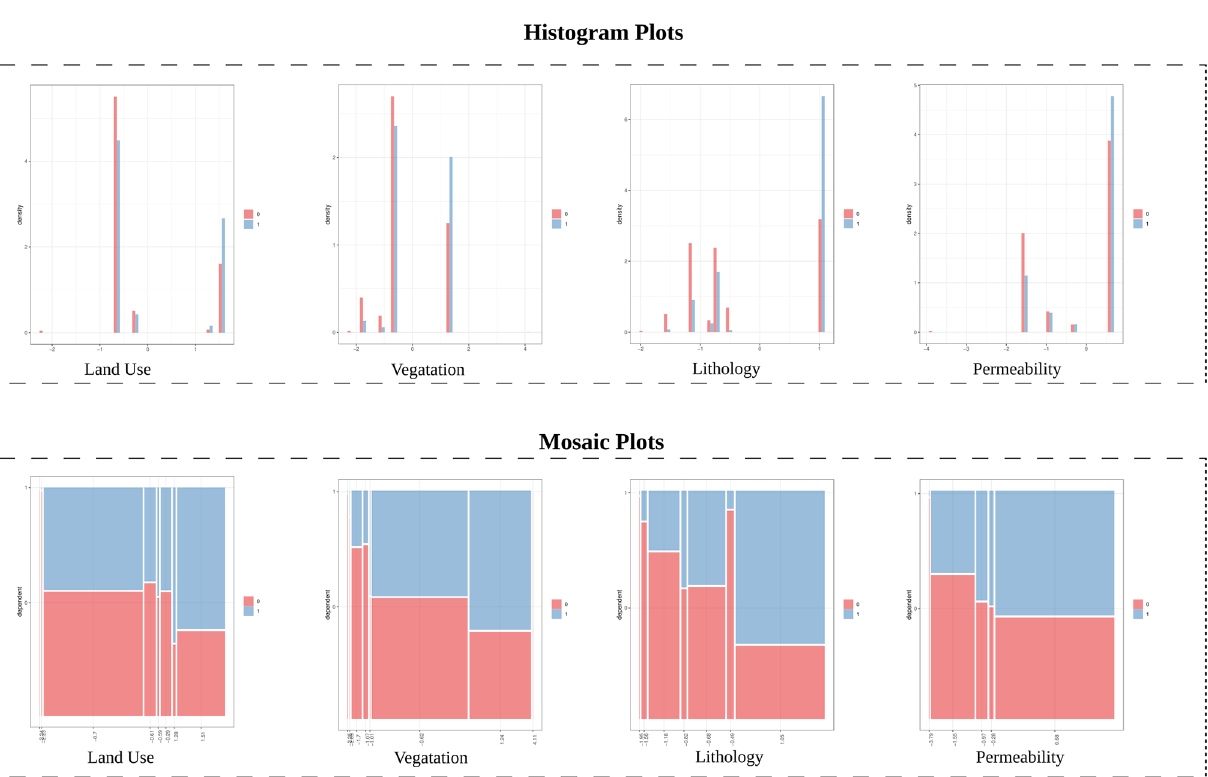
Geosci. Model Dev., 15, 5651–5666,